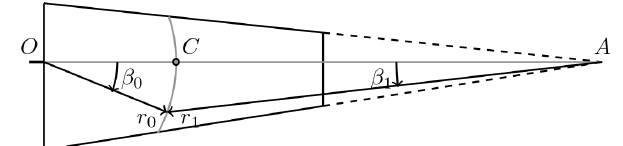
Figure 2. Conical parameters. O and A are the center of rotation and the cone apex, respectively. Lines of constant β 1 are the conical